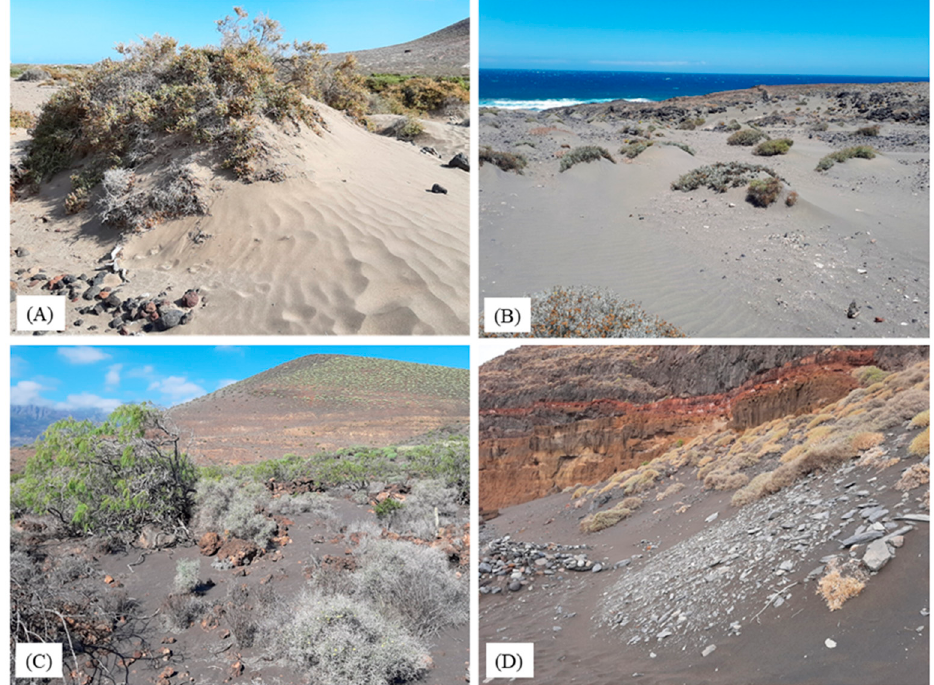
Figure 5. Different examples of active aeolian geoforms in Tenerife. ( A ): nebkha with ripples (El Médano); ( B ): nebkhas with shadow dunes (Montaña Pelada); ( C ): sand sheets (Malpaís de Güímar); ( D ): climbing dunes (Antequera). Source: authors.